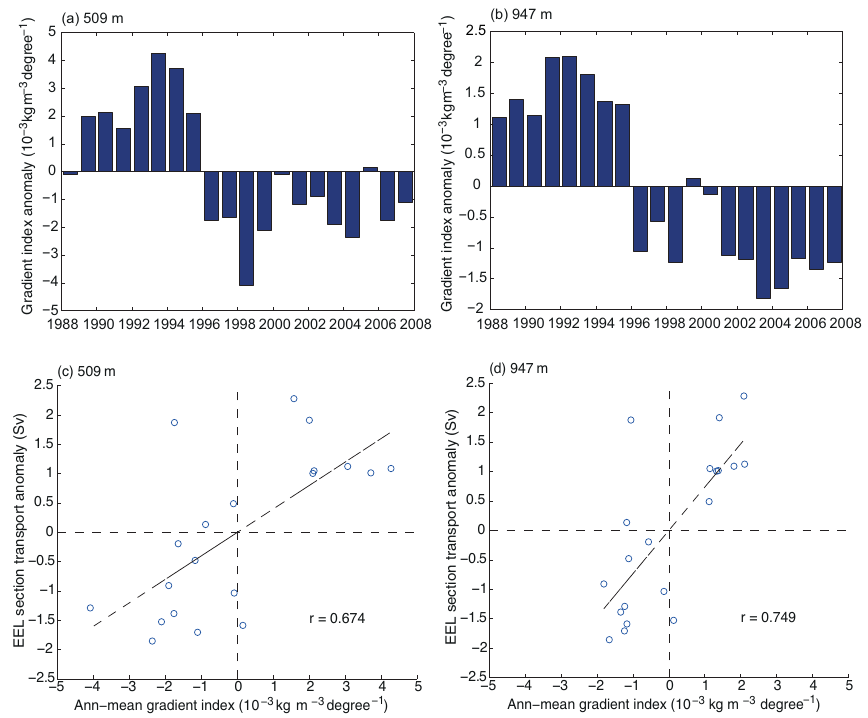
Figure 7. Time series over 1988–2007, in ORCA12-N01, of anomalies in density gradients averaged across 15–28 ◦ W and annually, for 509m (a) and 947m (b) – (d) , plotted against annual-mean Slope Current transports at the EEL section.